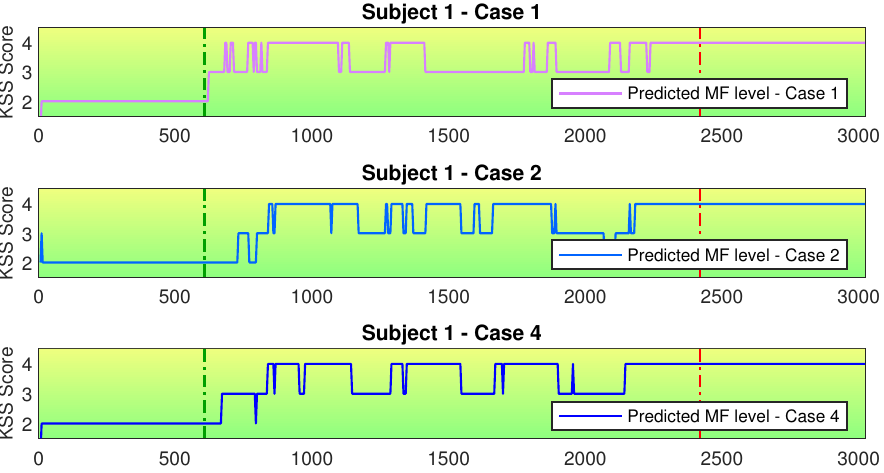
Figure 9. MF assessment for different cases for Subject 1. The horizontal axis is presented in seconds. The vertical green dashed line marks the superior limit of the data used for training the non-fatigue condition. The vertical red dashed line marks the inferior limit of the data used for training the fatigue condition. Different cases present good agreement among